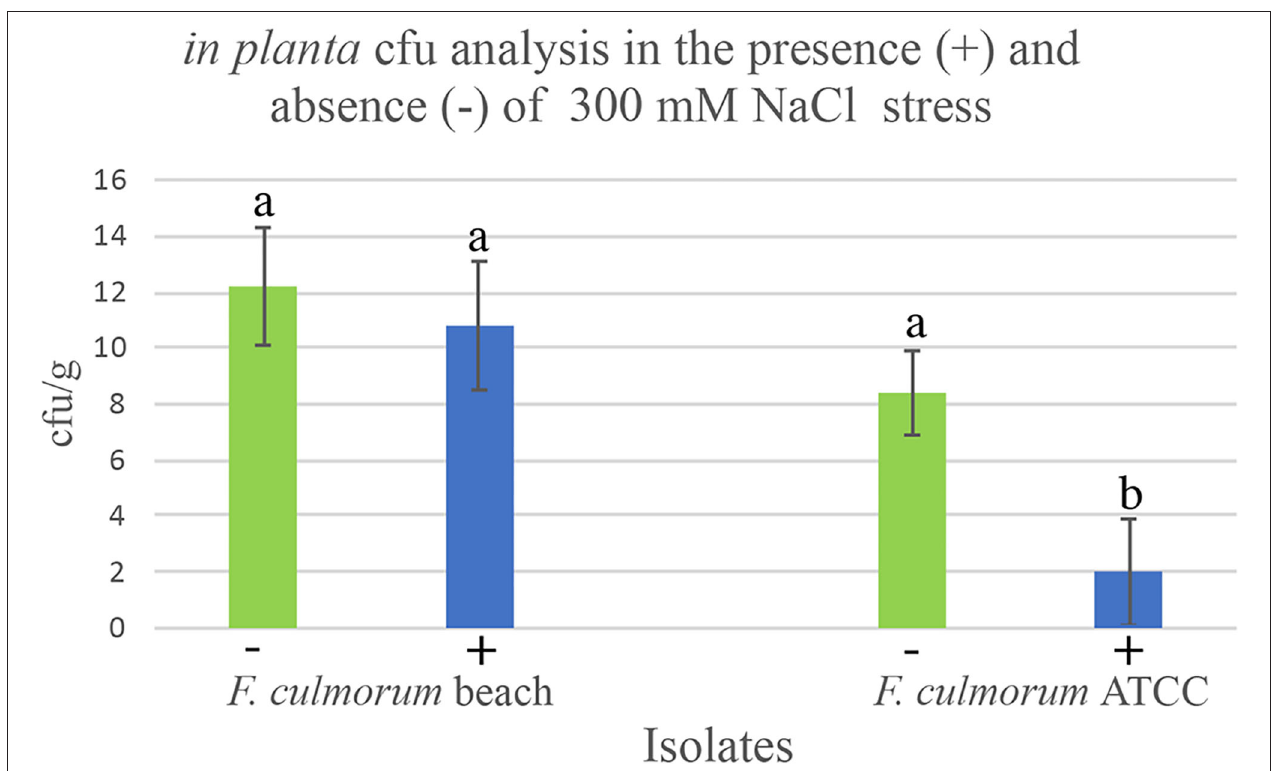
FIGURE 4 | Modulation of endophytes in planta dunegrass ( Leymus mollis ). Laboratory studies were conducted in double-decker magenta boxes with four-week-old dunegrass plants (x5 plants/magenta box, x3 reps of each treatment) colonized with F. culmorum beach isolate that does impart salt tolerance or F. culmorum ATCC isolate that does not impart salt tolerance, exposed either to no (0mM NaCl; green bars) or high salt stress (300mM NaCl, blue bars) for 7 days. When visible stress symptoms were observed in the F. culmorum ATCC isolate, the lower stem and roots of five plants were pooled and processed for cfu analysis by grinding plant tissues in an osmotic solution and plating aliquots onto fungal growth media (0.1x PDA). The in planta cfu abundance of the F. culmorum beach isolate remained the same in the presence and absence of salt stress. In contrast, in the presence of salt stress, the abundance of F. culmorum ATCC isolate decreased significantly. In each graph, ± standard deviation bars are indicated and the different lowercase letters above the bars indicate significant differences (Duncan’s Grouping; P <